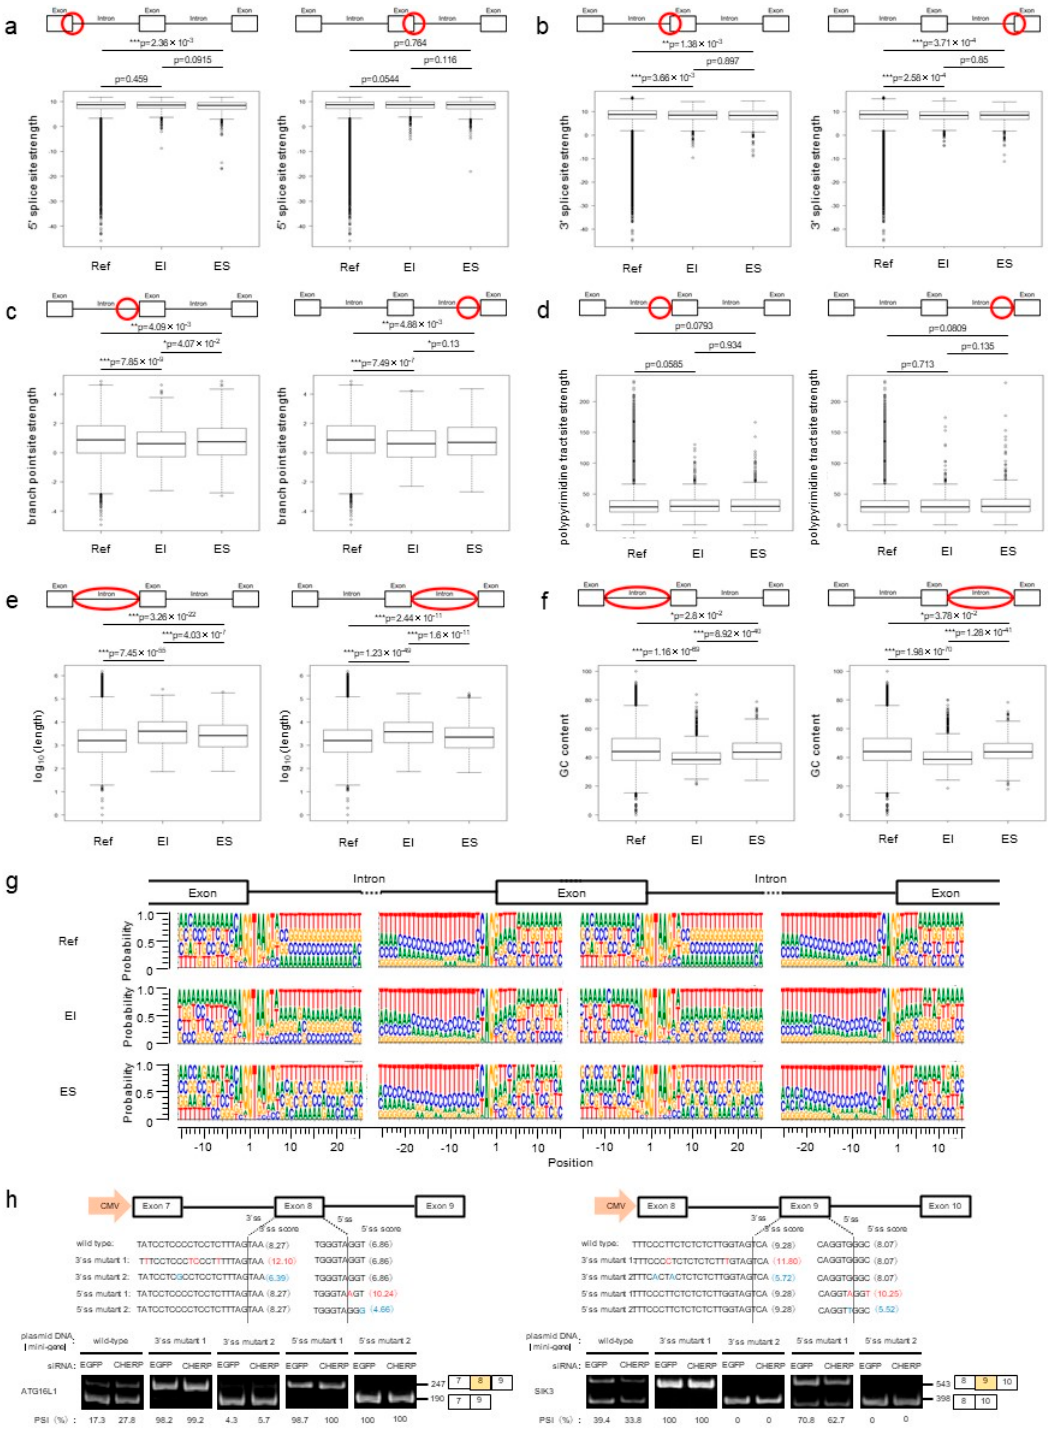
Figure 5. Characteristics of EI and ES induced by CHERP depletion. ( a , b ) 5 ′ and 3 ′ splice site scores after CHERP depletion, calculated by MaxEntScan. ( c ) Branch point site scores after CHERP depletion, calculated by SVM-BPfinder. ( d ) Polypyrimidine tract site scores after CHERP deple- tion, calculated by SVM-BPfinder. ( e , f ) Length and GC content of CHERP-targeted introns, ana- lyzed by BedTools. ( a – f ) FDR < 0.05, inclusion or skipping count ≥ 10, and IncLevelDifference ≤ – 0.1 (EI) or IncLevelDifference ≥ 0.1 (ES) were considered significantly different. For statistical anal- ysis, Wilcoxon rank sum test was used to calculate p -value. * p < 0.05, ** p < 0.01, *** p < 0.001. ( g )